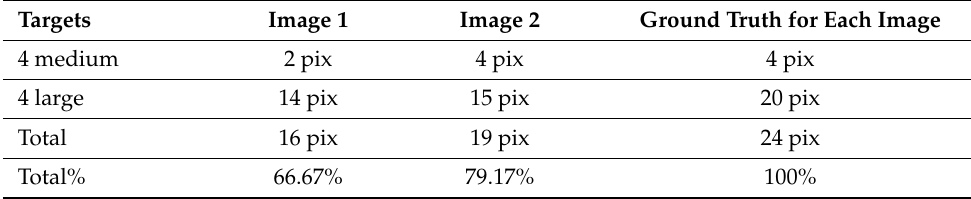
Table 5. True-positive results in the configuration